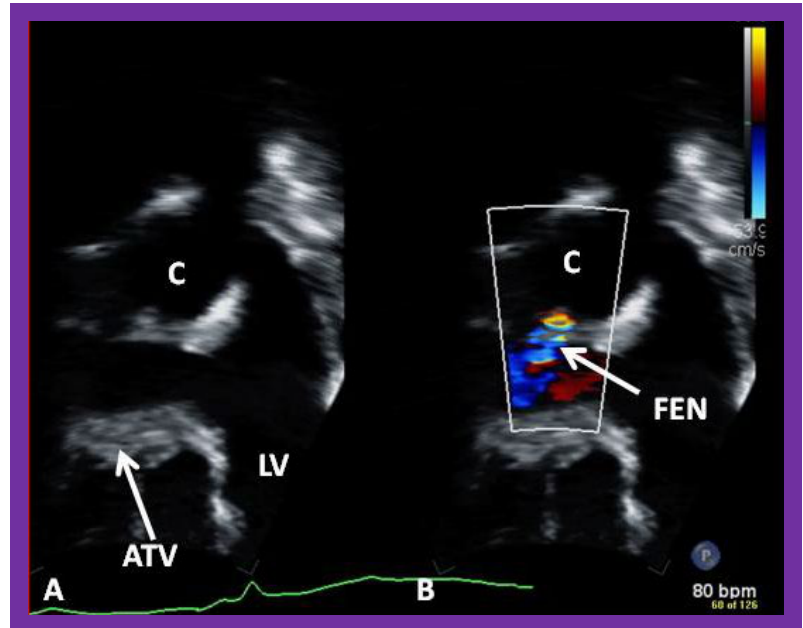
Figure 50. Selected video frames from an apical four chamber view, similar to Figures 39 and 40, focusing on the conduit (C) (left) and with color flow imaging (right) demonstrating fenestration (FEN). ATV, atretic tricuspid valve; LV, left ventricle.